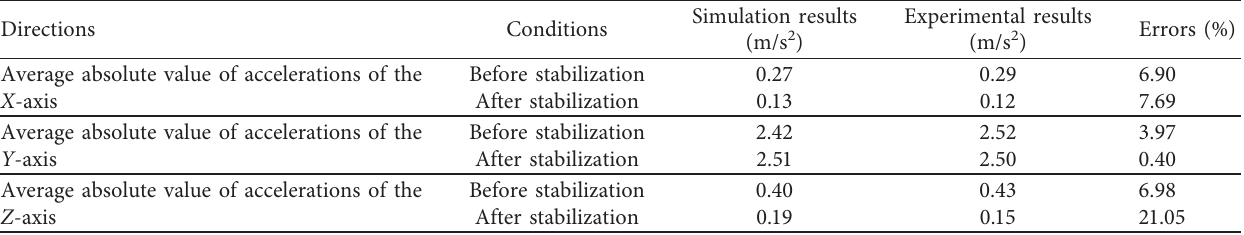
Table 7: Analysis and comparison of experimental frequencies and simulation frequencies. Directions Orders Frequencies of the X -axis Frequencies of the Y